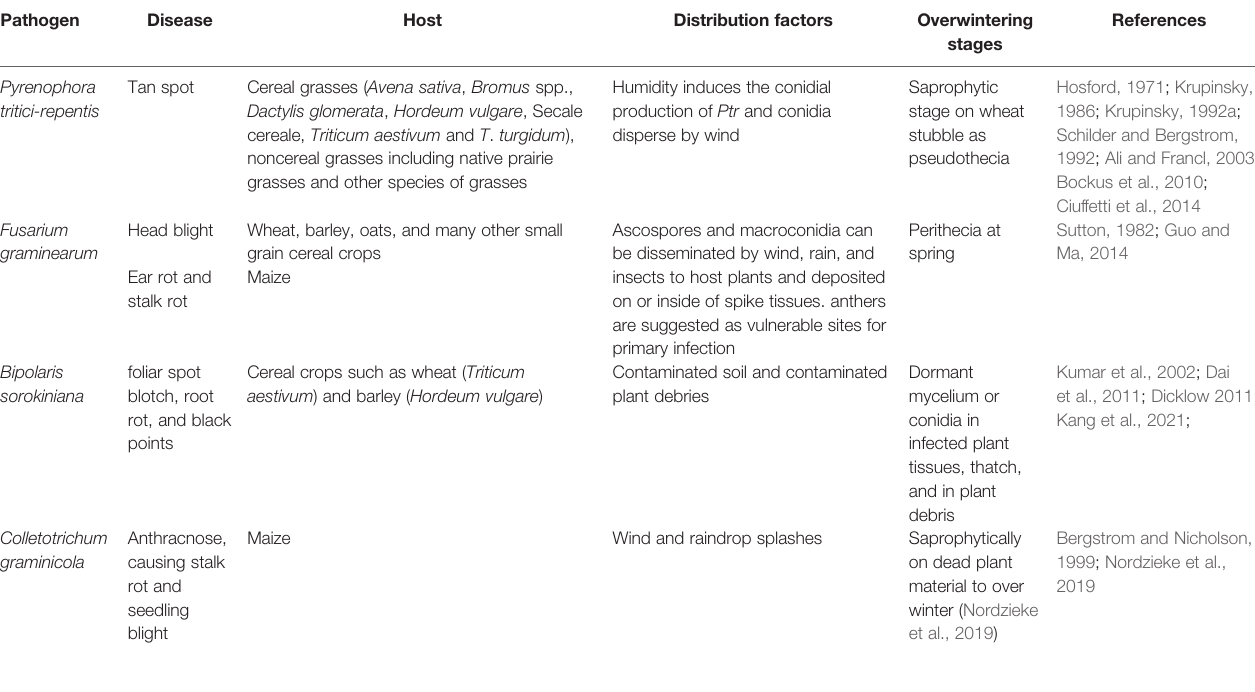
TABLE 1 | Host, distribution factors and overwintering stages of selected fungal pathogens.